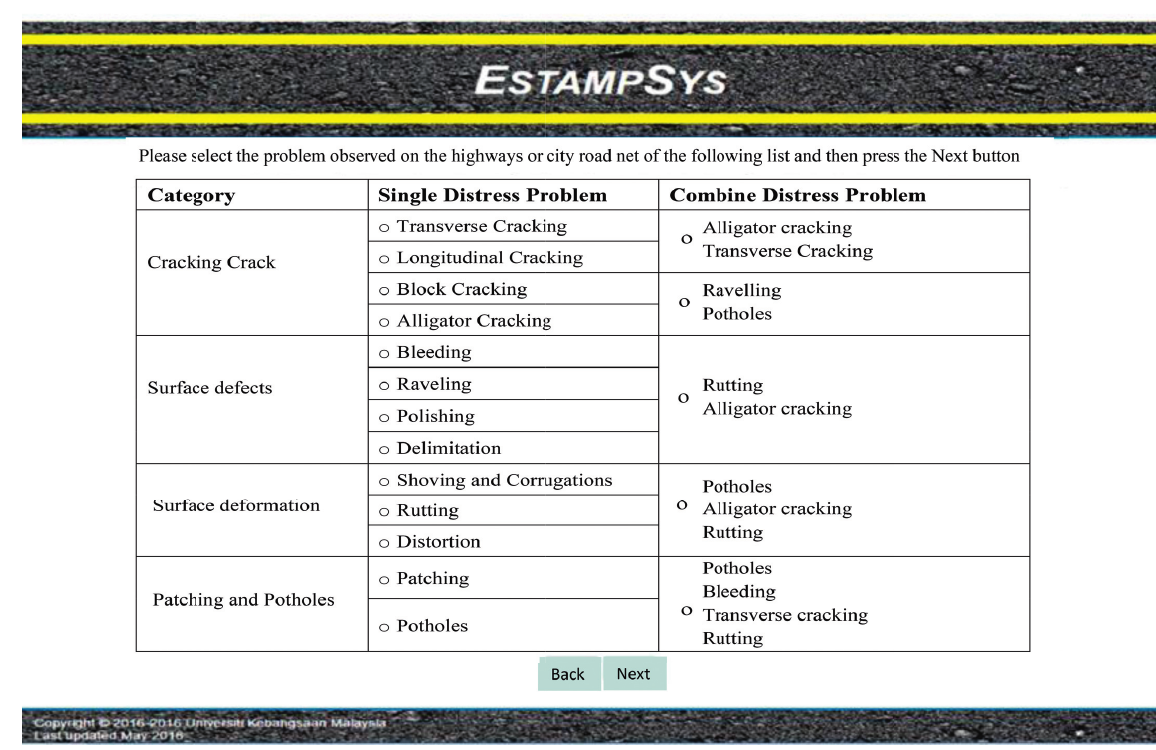
Figure 6: Screenshot of the flexible pavement distress